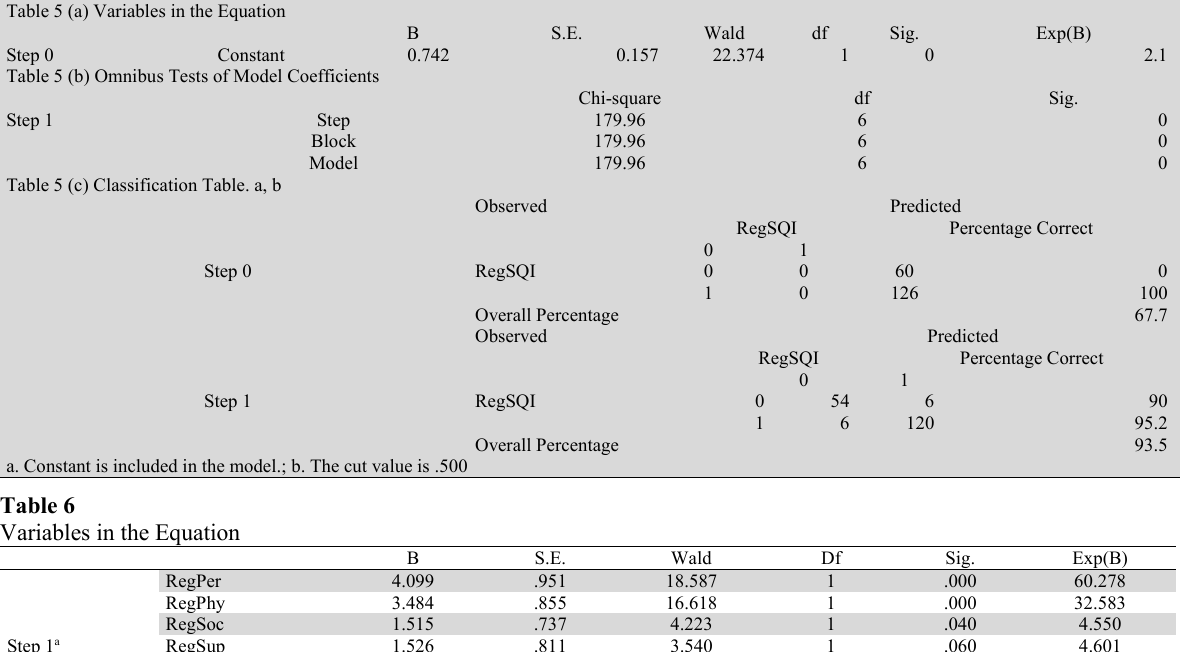
Binary Logistic Regression Table 5 (a) Variables in the